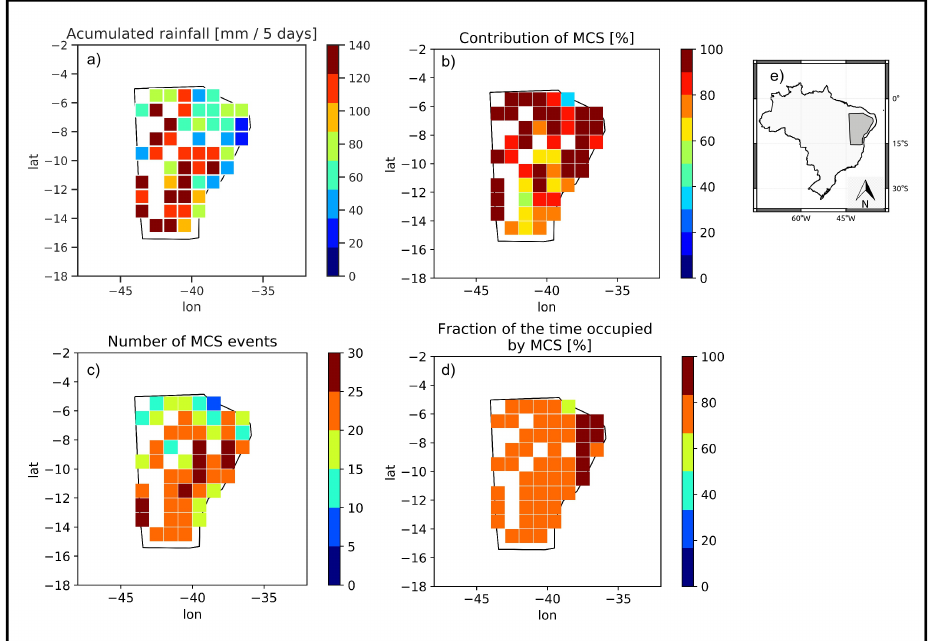
Figure 12. ( a ) Accumulated rainfall recorded from 20 January 2016 to 24 January 2016 in the Northeast- ern region of Brazil (R3); ( b ) fraction of rain on days that had MCS records over the rain accumulated in five days; ( c ) number of MCS events recorded in five days; ( d ) fraction of the days that had MCS records; ( e ) analyzed region.